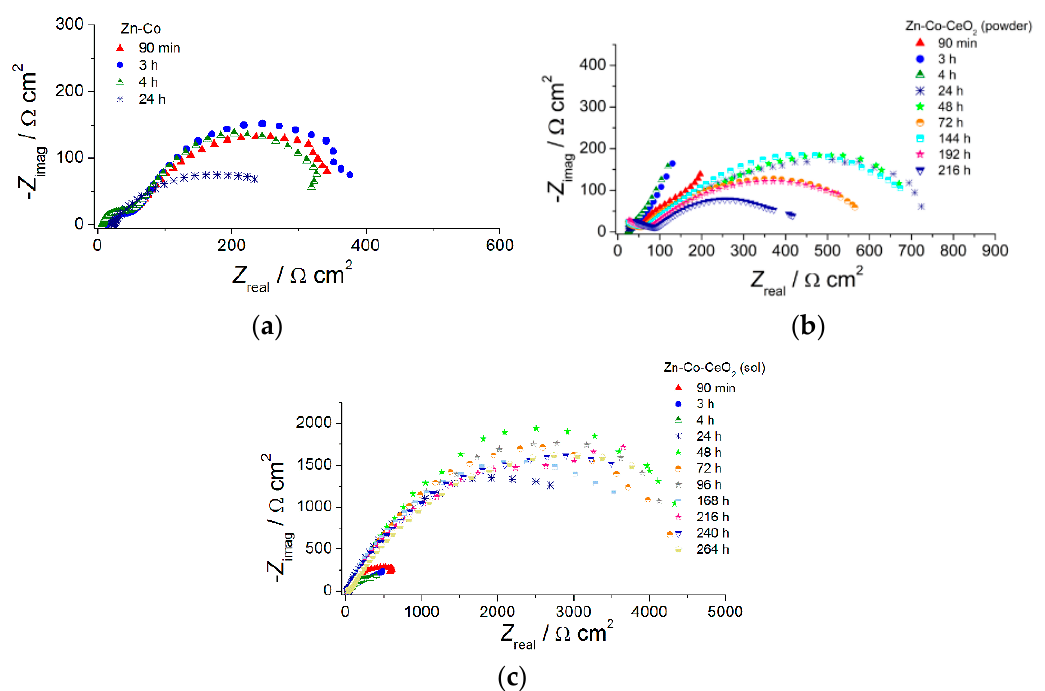
Figure 11. The Nyquist plots of ( a ) Zn-Co, ( b ) Zn-Co-CeO 2 (CeO 2 powder) and ( c ) Zn-Co-CeO 2 (CeO 2 sol) composite